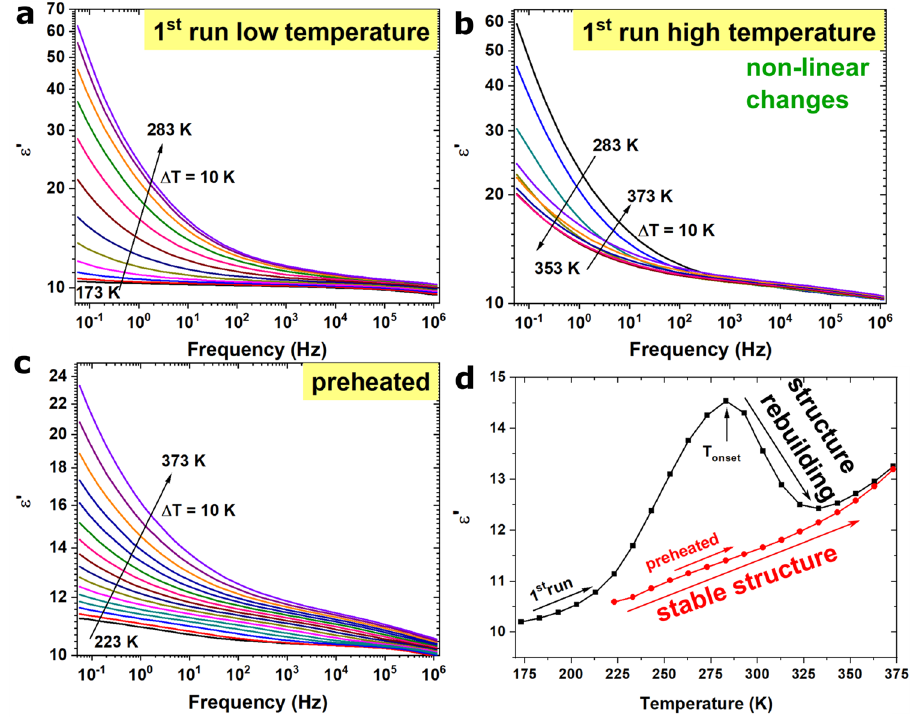
Figure 2. Dielectric spectra of BiOCl plates: ( a ) real part of complex permittivity as a function of temperature measured for as-synthesized, compressed sample; ( b ) real part of complex permittivity as a function of temperature measured in the high-temperature region, with marked nonlinear changes; ( c ) real part of complex permittivity as a function of temperature measured for preheated BiOCl plates; ( d ) influence of temperature on the real part of complex permittivity plotted for the sample before (1st run) and after heat treatment (2nd run), with the temperature of the thermally-activated process